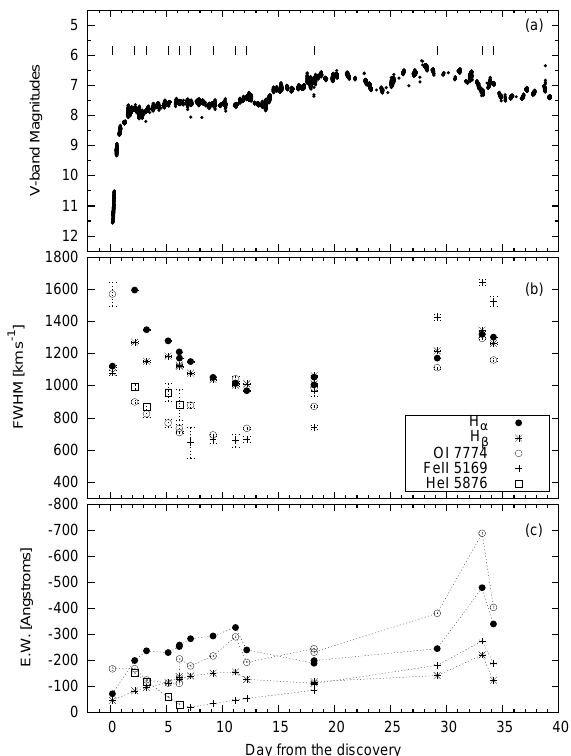
Figure 1: (a) The V-band light curve of the early phase of T Pyx 2011 quoted from AAVSO database. Short tics denote epochs of our observations. (b) The FWHMs of prominent emission lines. (c) The equiva- lent widths for the same lines in the panel